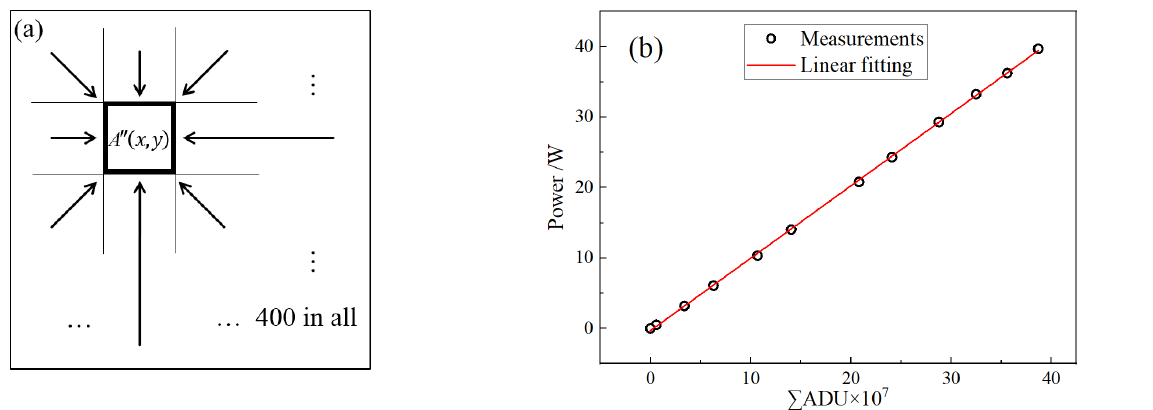
Figure 3. System diagram: the upper half of the diagram shows the light transmission process with ‐ out the homogenizer (part of the spots of the array), while the lower half shows the process with the homogenizer. ( a ) Different divergence angles of the output array beams without the homogenizer; ( b ) captured array spots with mutual crosstalk that are not easy to divide; ( c ) output beams that become array diffusers; ( d ) captured array spots with mutual crosstalk that can be predicted by the model and removed by the algorithm; ( e ) array spots after positioning and gridding; ( f ) array spots after crosstalk removal; and ( g ) restored spots.